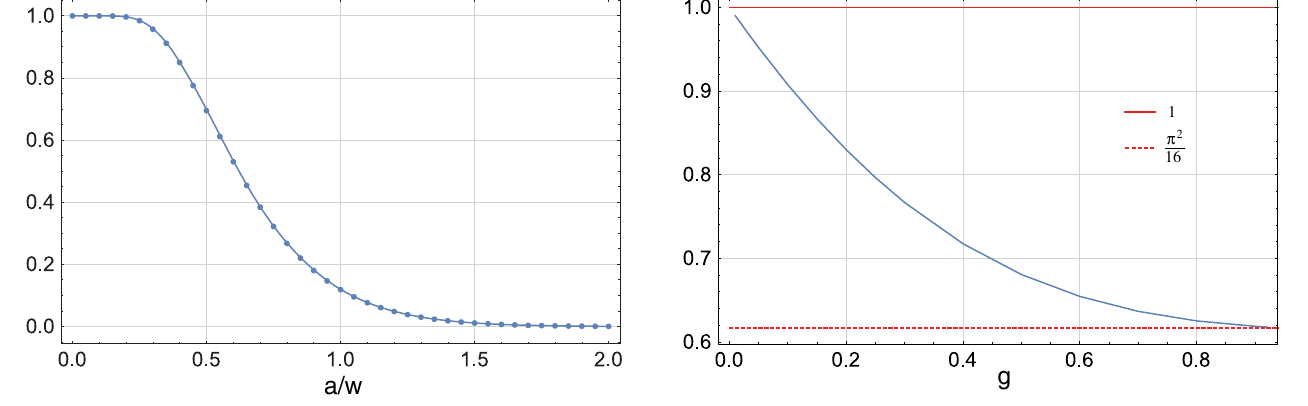
at the particle in the z , showing its dependence a 2